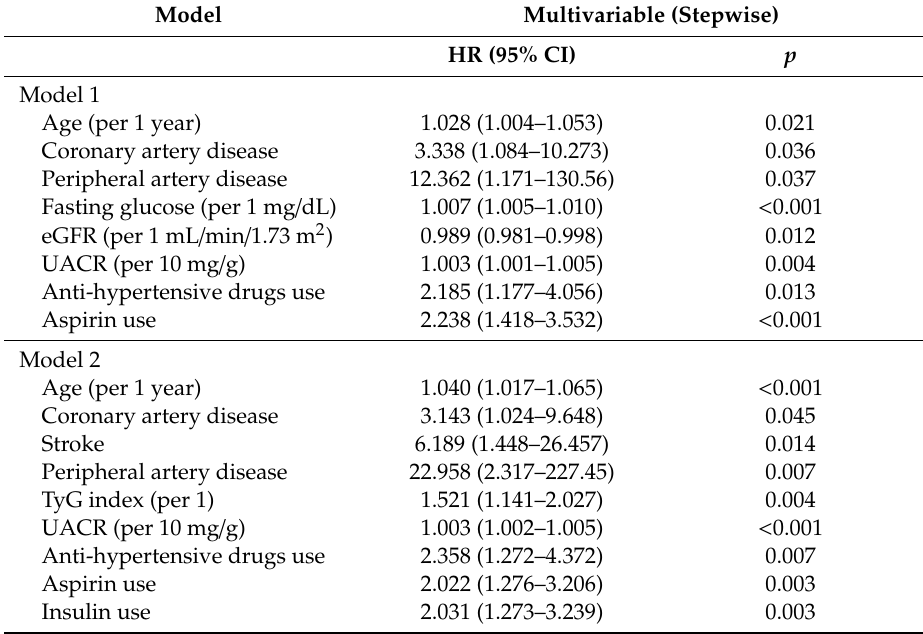
Table 3. Determinants for cardiovascular events using the Cox proportional hazards model (multivariable stepwise analysis).